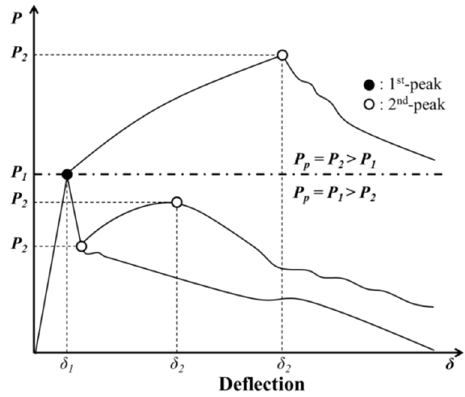
Figure 1. Typical load ‐ deflection responses of FRC.